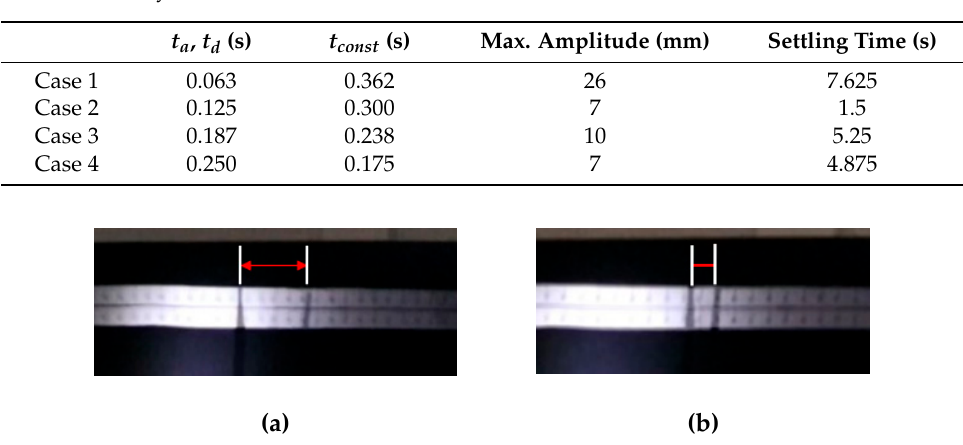
Table 4. Experimental results of maximum amplitude and settling time when moving 425 mm with a maximum velocity of 1000 mm/s.